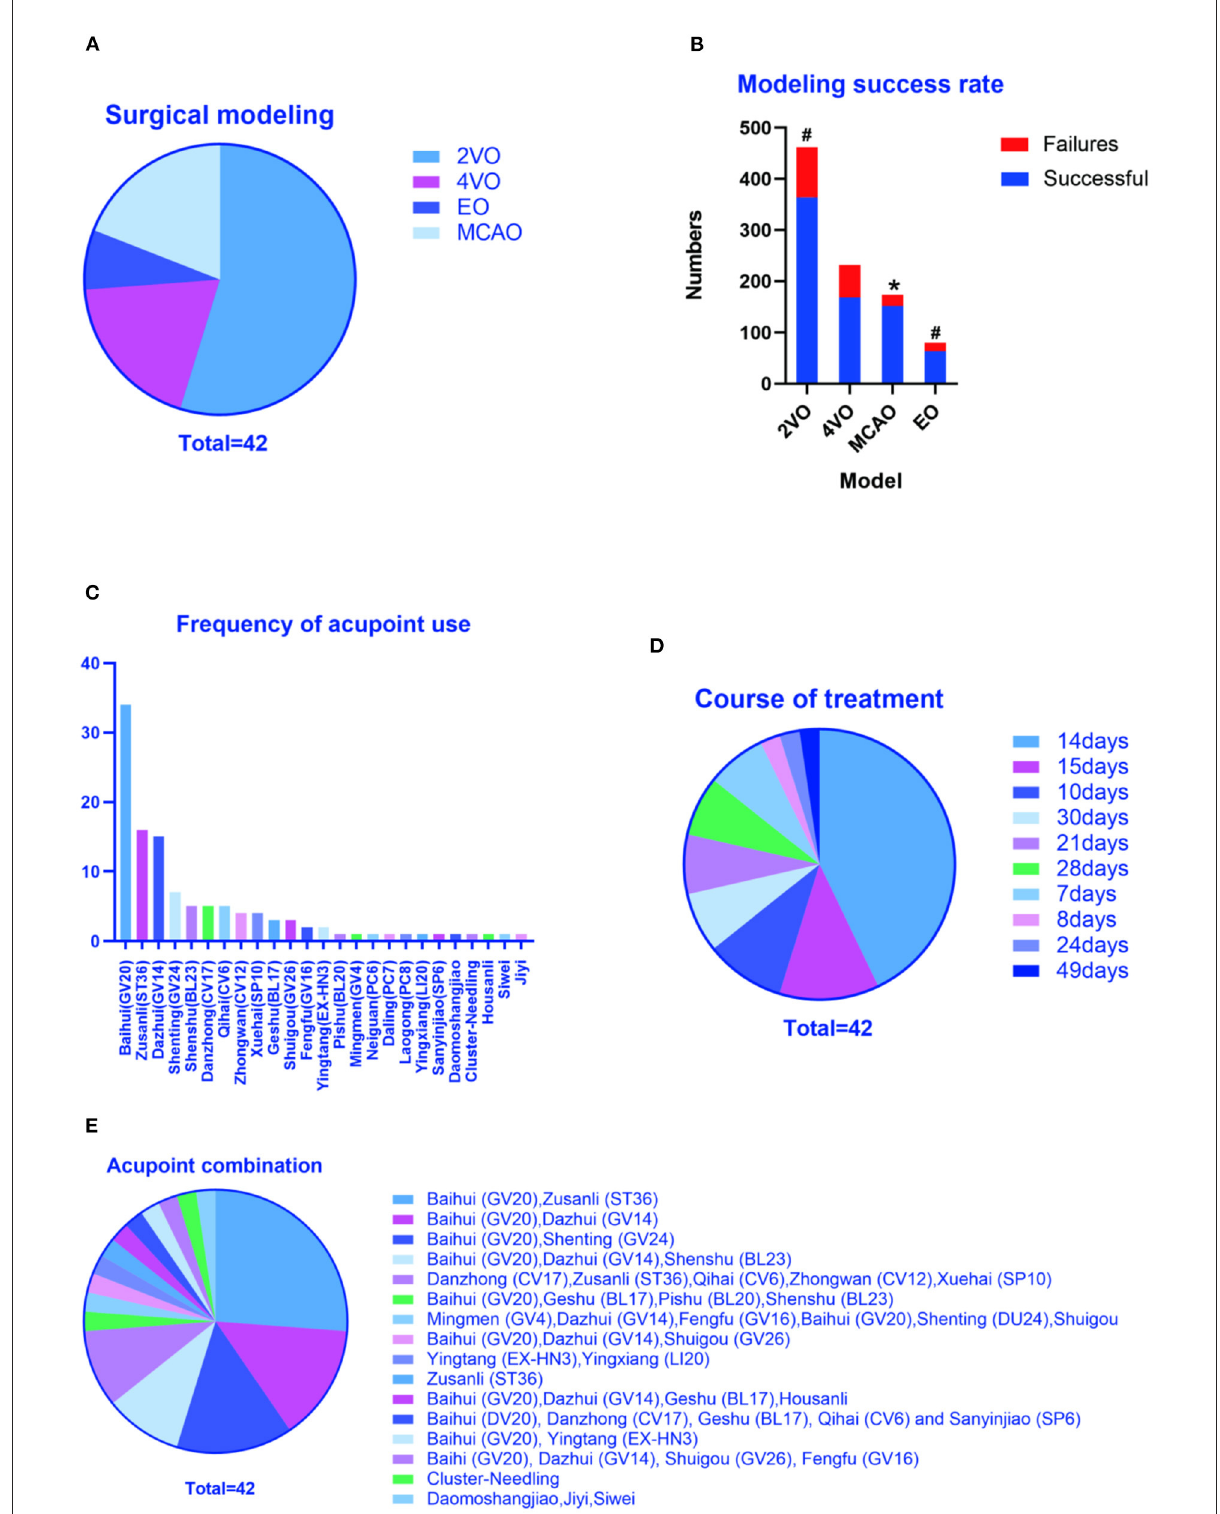
FIGURE1 Study characteristics. (A) Methods of surgical modeling, (B) Total number of modeling and the number of successful modeling, (C) Frequency of acupoint use, (D) Total course of treatment, (E) Frequency of acupoint combination. 2VO, Two - Vessel Occlusion or Bilateral Common Carotid Artery Occlusion; 4VO, Four-Vessel Occlusion; MCAO, Middle Cerebral Artery Occlusion; EO, Embolic occlusion, * P < 0.05 (Modeling success rate of MCAO VS 2VO, EO and 4VO, MCAO had the highest success rate). # P < 0.05 (Modeling success rate of 2VO VS 4VO and EO VS 4VO, no difference between 2VO and EO, and the lowest is